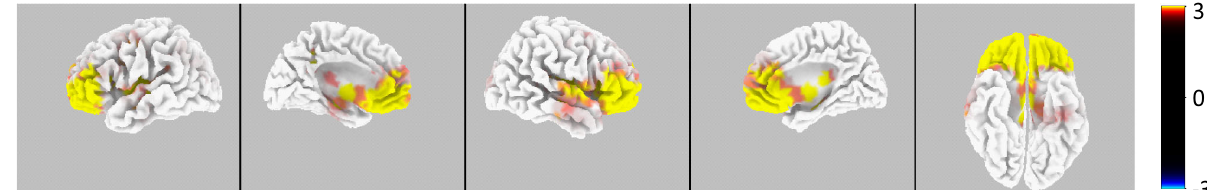
Fig. 5 Source difference of working memory gating dynamics between 400 and 750 ms. The source difference was computed using gate opening independent component (IC) pair 4 and gate closing IC pair 4. The source difference of the working memory gating dynamics is illustrated from fi ve orientations (from left to right: lateral-left, medial-left, lateral-right, medial-right, and bottom). The color bar represents the critical t -values using N = 33 samples. The color key on the right denotes t -values.